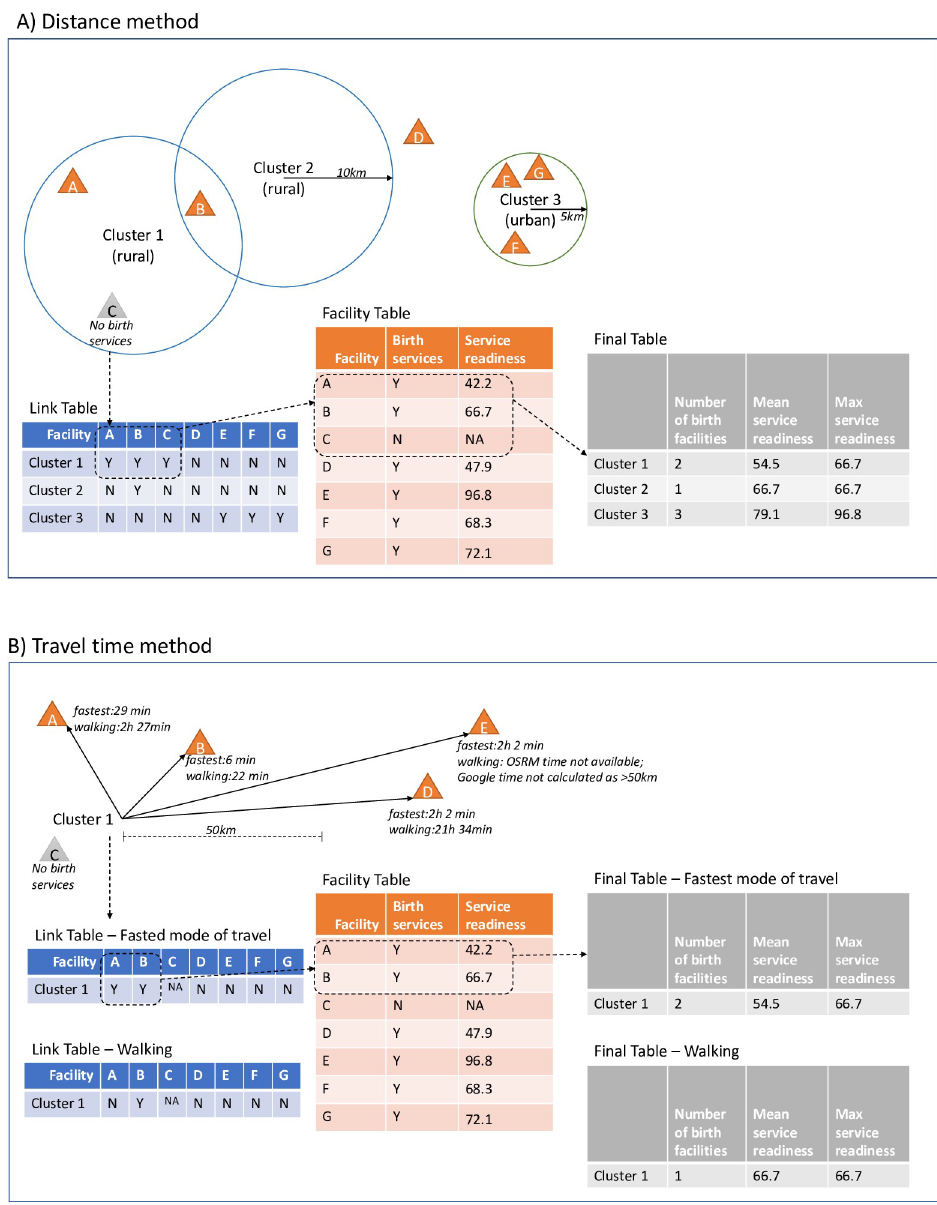
Fig 1. Illustrative example of household cluster and facility